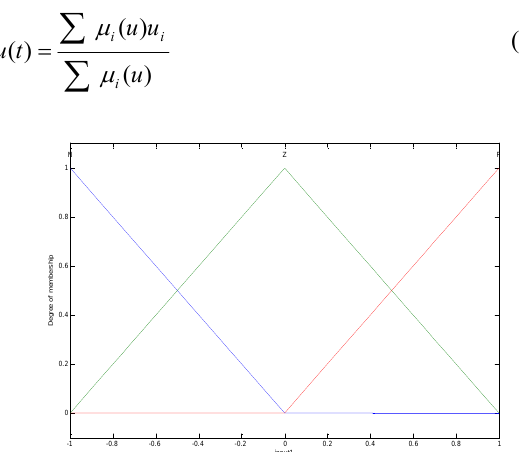
Fig. 4. Membership functions of input and output variables for Fuzzy Precompensated Controller